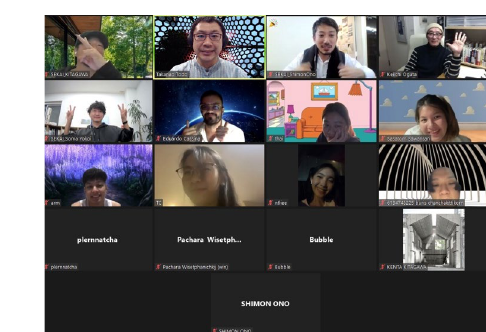
Figure 23 Lecture and a student’s work from